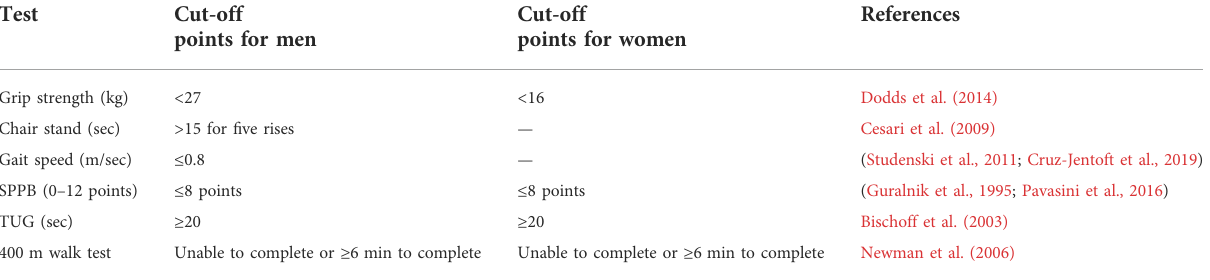
TABLE 1 European working group on sarcopenia in older people cut-off points. (Cruz-Jentoft et al., 2019).